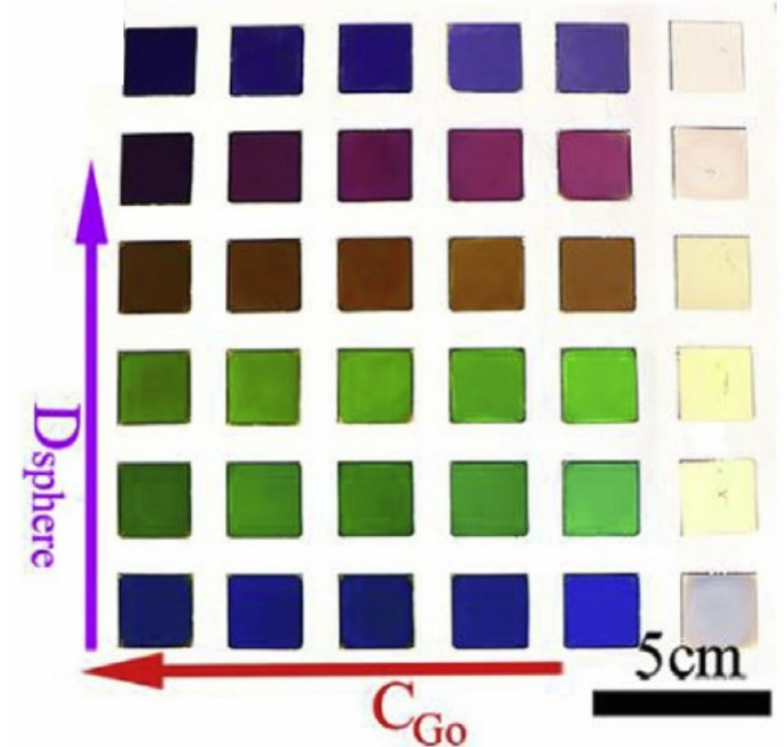
Figure 14. Image of the color cards. The diameter of PS particles gradually increases from bottom to top and the concentration of GO gradually increases from right to left (Reproduced with permission from ref. [83]. Copyright 2019 Elsevier